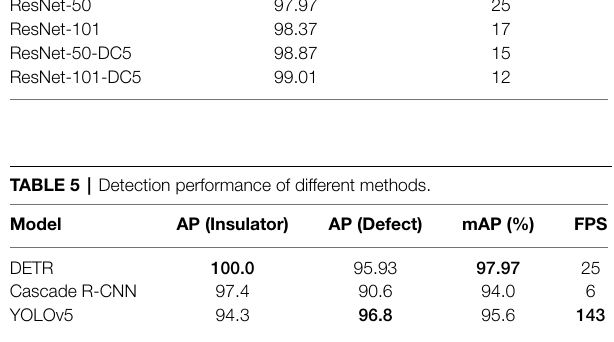
TABLE 3 | Training parameter settings of DETR.